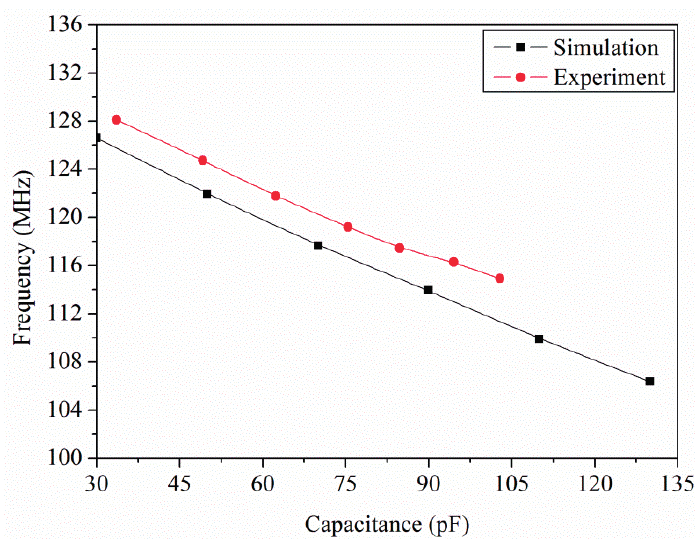
Figure 13. Relation between output frequency and capacitance for the sensor.